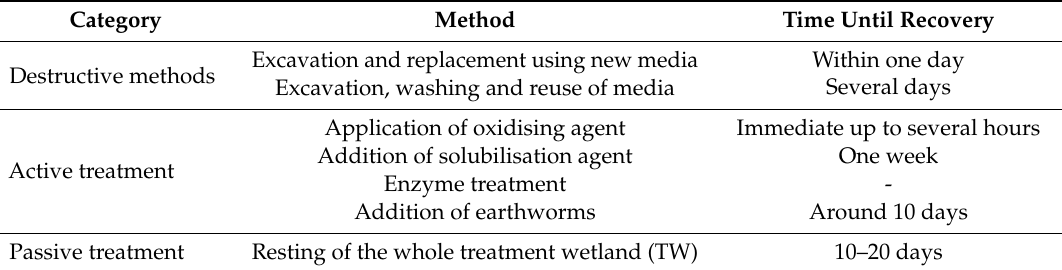
Table 2. Available remediation strategies for clogged